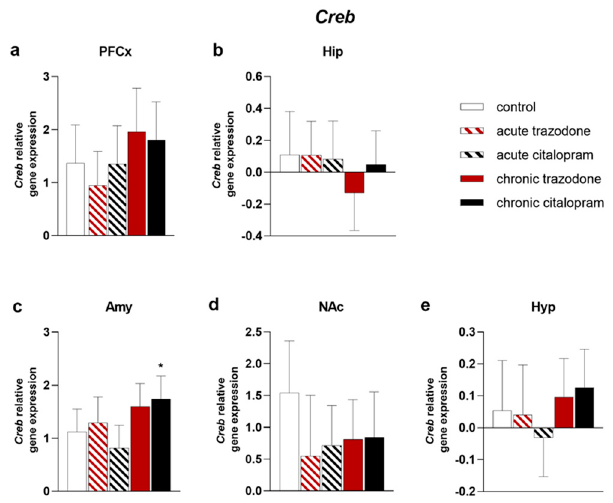
Figure 5. mRNA levels of Creb in the PFCx ( a ), Hip ( b ), Amy ( c ), NAc ( d ), and Hyp ( e ) after acute or chronic treatment with trazodone, citalopram, or vehicle. The least square predicted means with 95% confidence intervals are plotted. Data were log-transformed when required to stabilise the variance and satisfy the parametric assumptions ( b , e ). *: p < 0.05 in the Planned Comparison vs. control. n = 6/group.